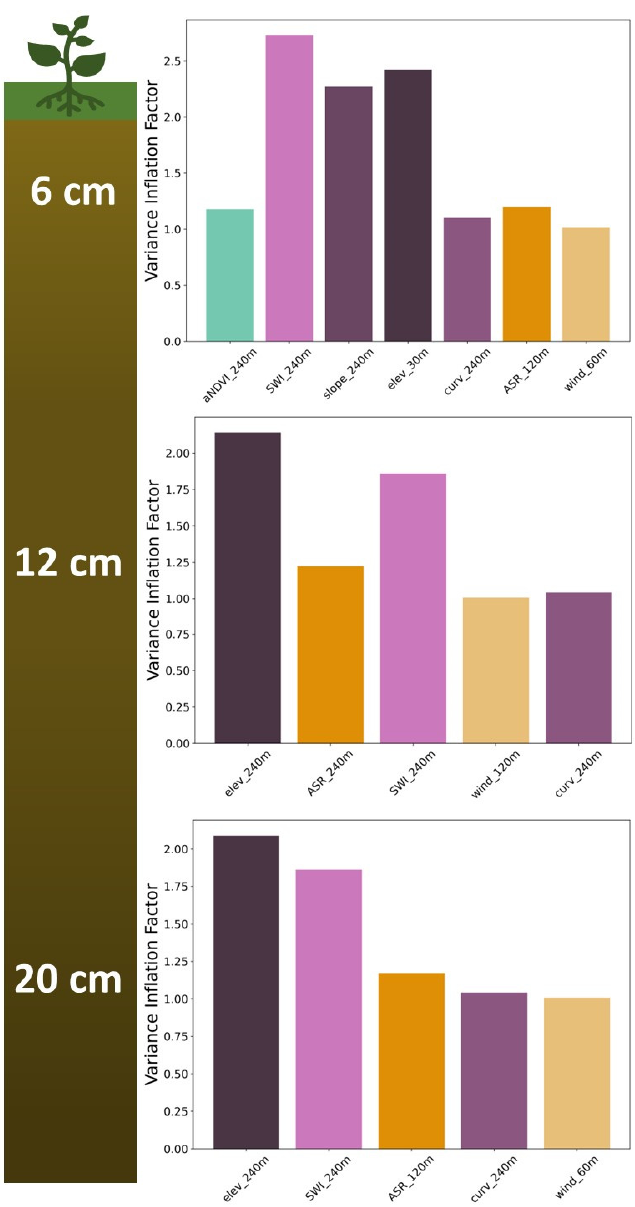
Figure A1. Wind factor illustration for an easterly wind were derived similarly to the wind equa- tions found in Dvornikov et al 2015 [55]. .